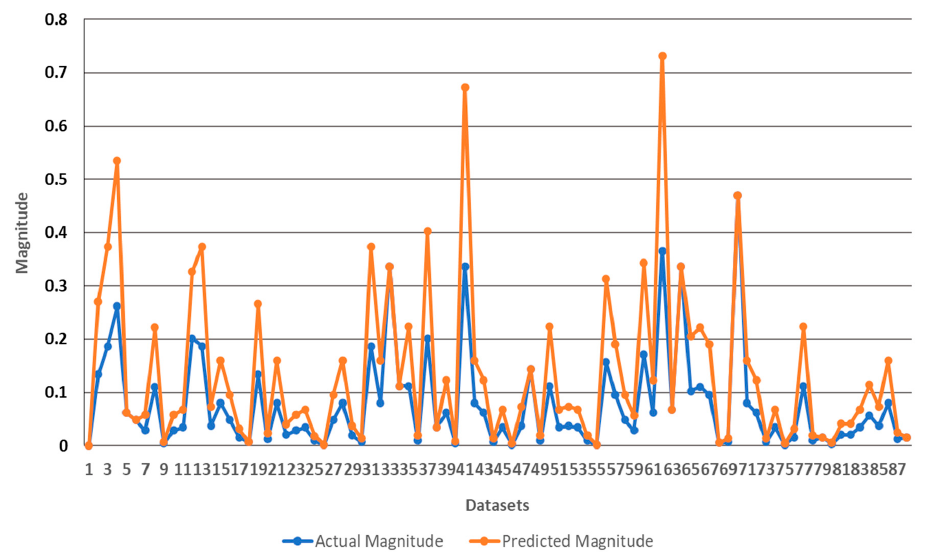
Figure 11. The comparison between actual versus predicted risk magnitudes of testing data sets. Table 10. Risk magnitudes and classifications of safety risks related to testing data sets and aggregation of all data sets.